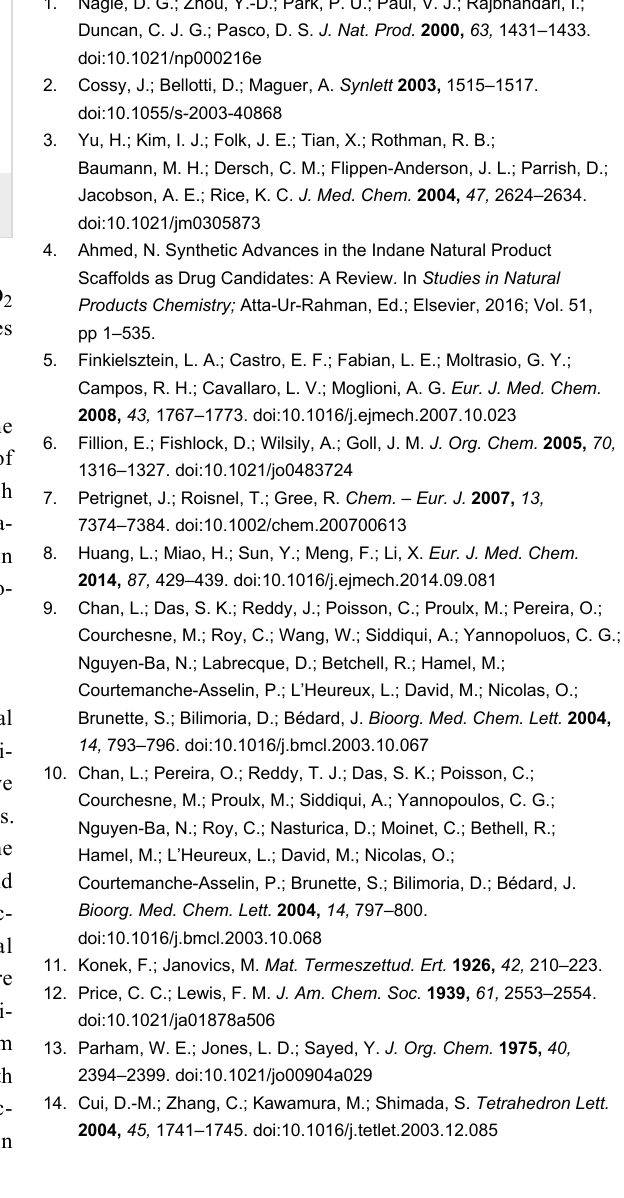
Figure 6: Chemical structures of obtained cyclopenta[ α ]phenan- threnes 339 .